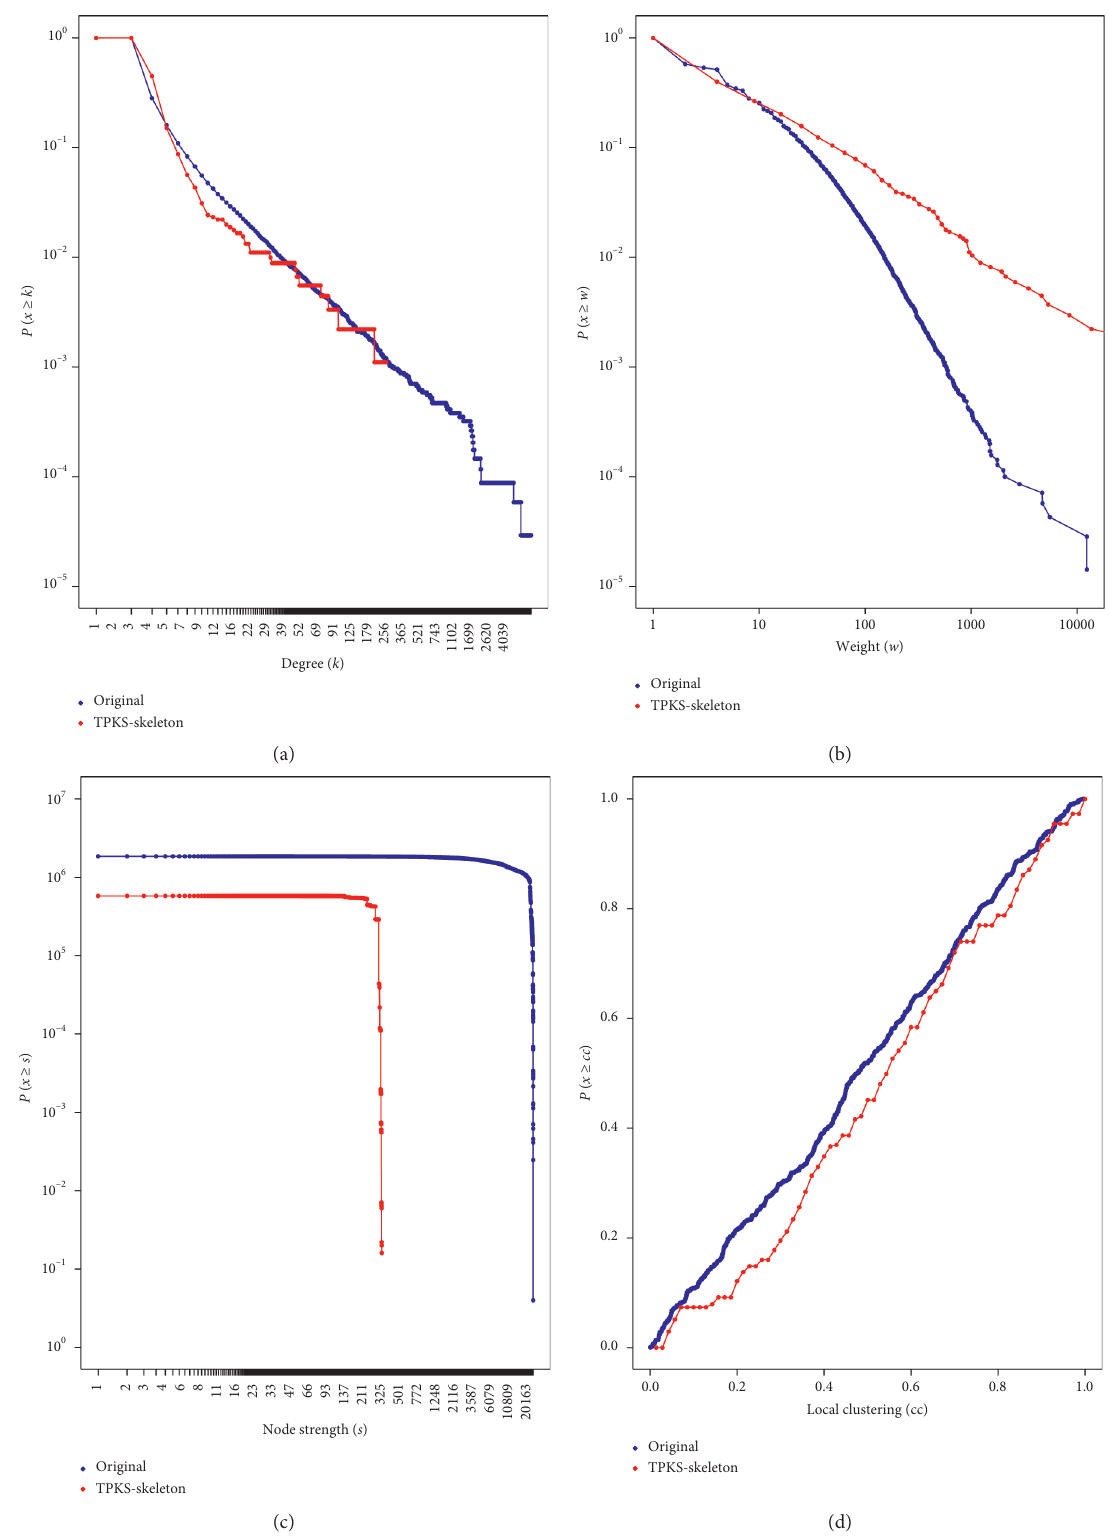
Figure 4: Basic network structural features of the original network and the extracted TPKS-skeleton: (a) the cumulative degree distribution, (b) the cumulative weight distribution, (c) the node strength distribution, and (d) the clustering